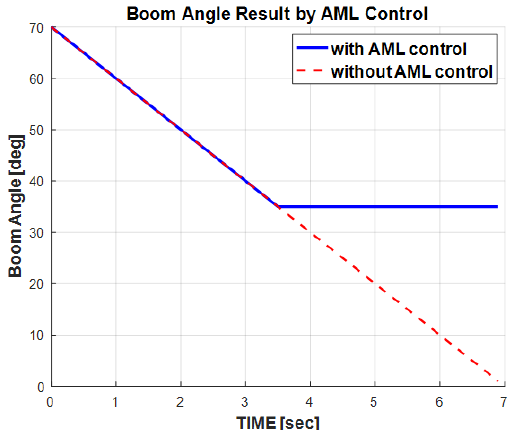
Figure 13. Simulation outputs of the derrick cylinder pressure.